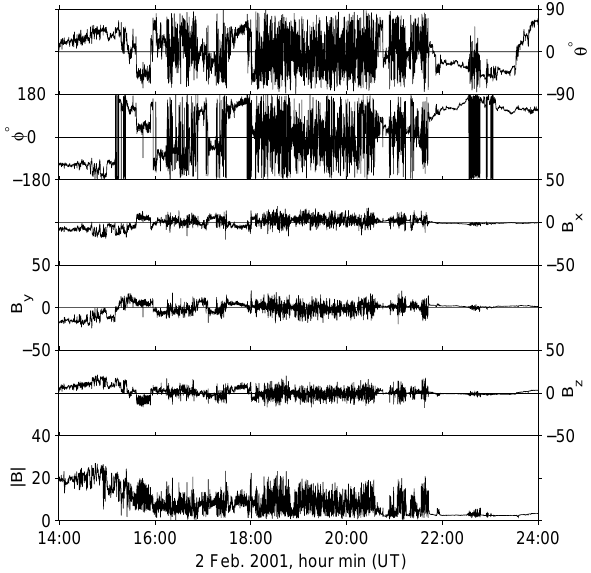
Fig. 1. Magnetic field data recorded by Cluster 4 through the quasi- parallel shock on 2 February 2001. Data are displayed in the GSE coordinate system. Panels show magnetic field elevation ( θ ) and longitude ( φ ) angles in degrees, three magnetic field components ( B x , B y , B z ) and the magnetic field magnitude | B | in nT. from the timing of the shock crossings at the four spacecraft.